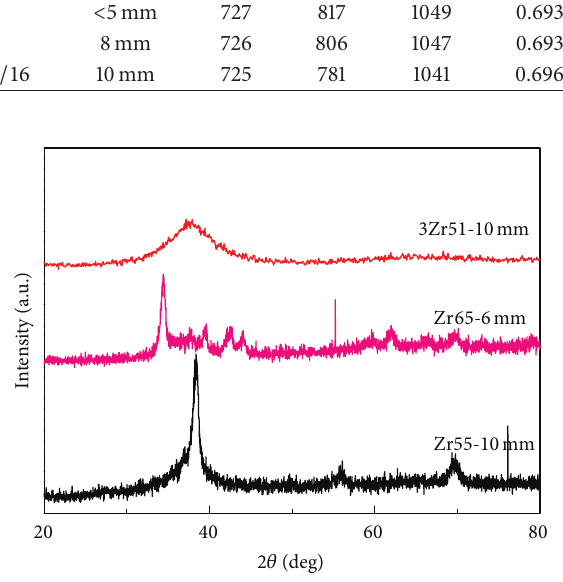
Figure 4: The XRD patterns for previously reported as-cast Zr- based amorphous alloy samples in different